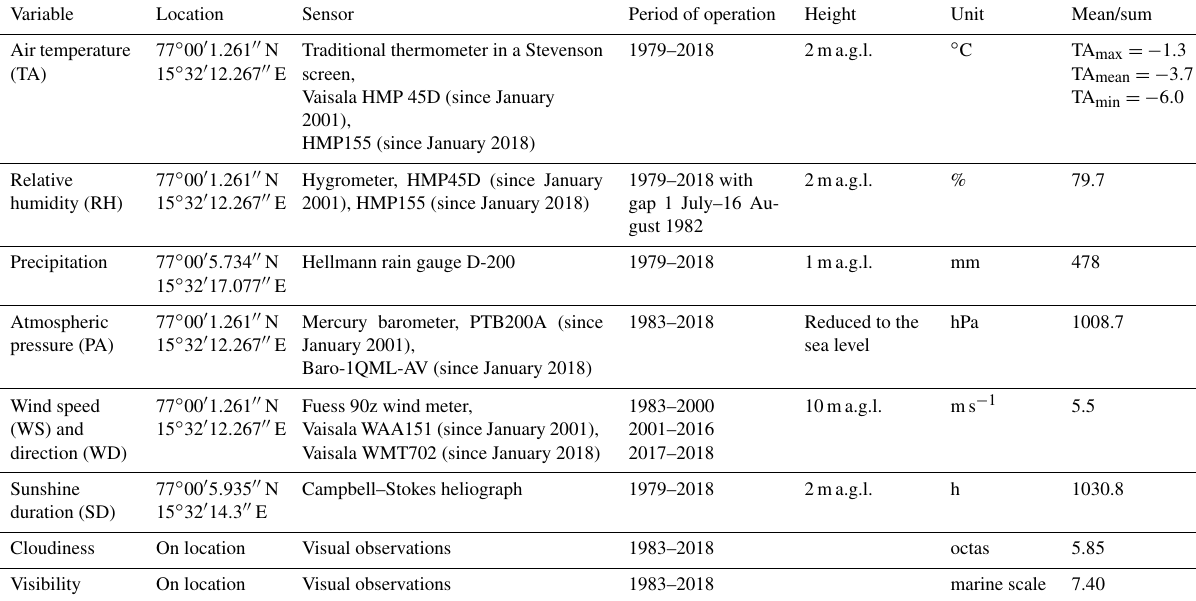
Figure 1. Polish Polar Station Hornsund on Spitsbergen in the Svalbard archipelago. Table 1. Meteorological data measured at Hornsund including variables, current sensors, the period of operation, height, units, and their annual averages or